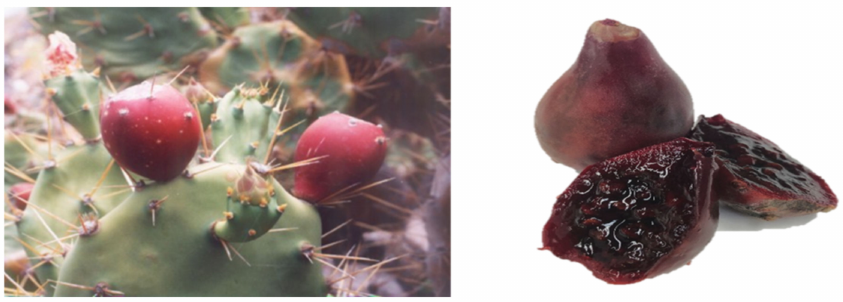
Figure 1. Opuntia stricta var. Dillenii cactus and cactus from Canary Islands,